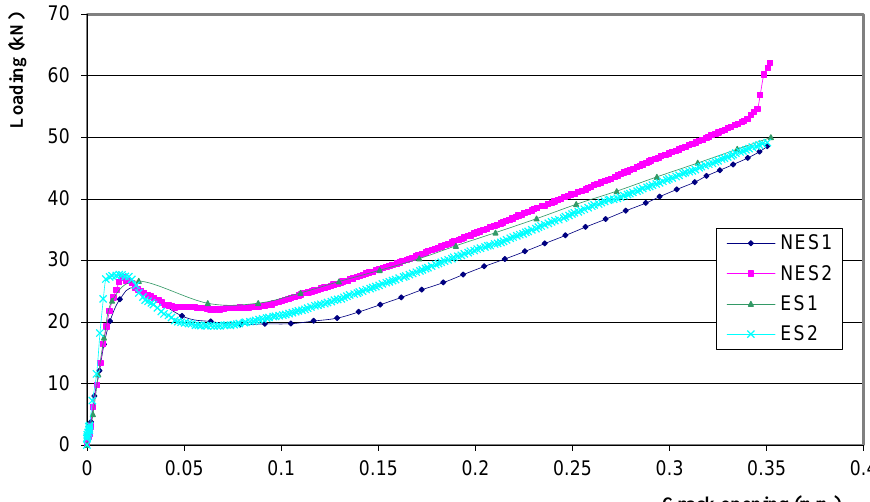
Figure 5. Evolution of the crack opening with loading during the pre-cracking phases of NES2, ES1 and ES2 and the beginning of the monotonic loading of NES1 (N.B. ES1 and ES2 were strengthened by CFRP after their pre-cracking phase).